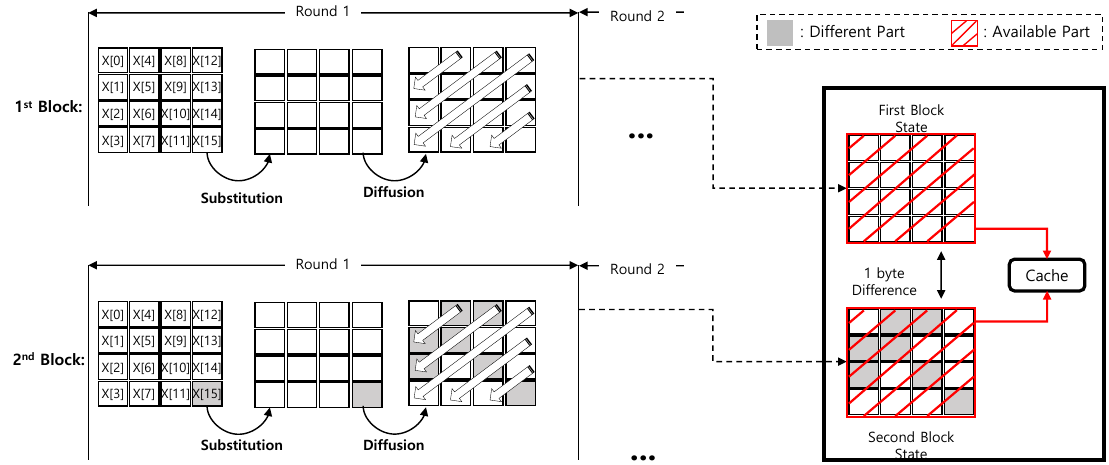
Figure 4. Difference between first and second blocks in Round 1 of ARIA-CTR mode of